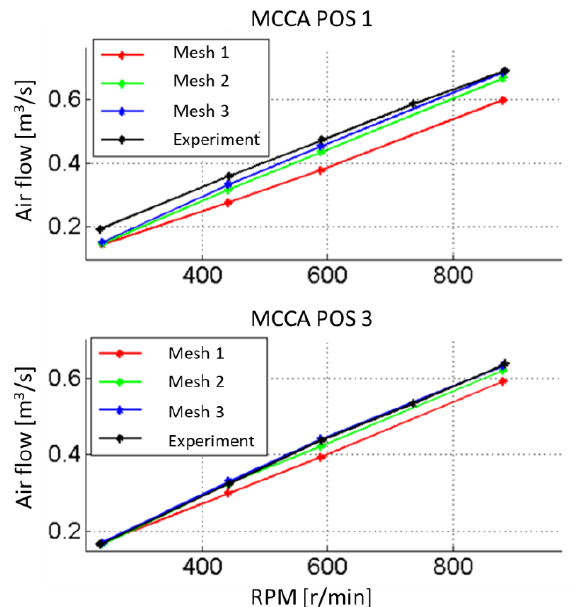
Fig. 5. CFD simulation sensitivity on mesh